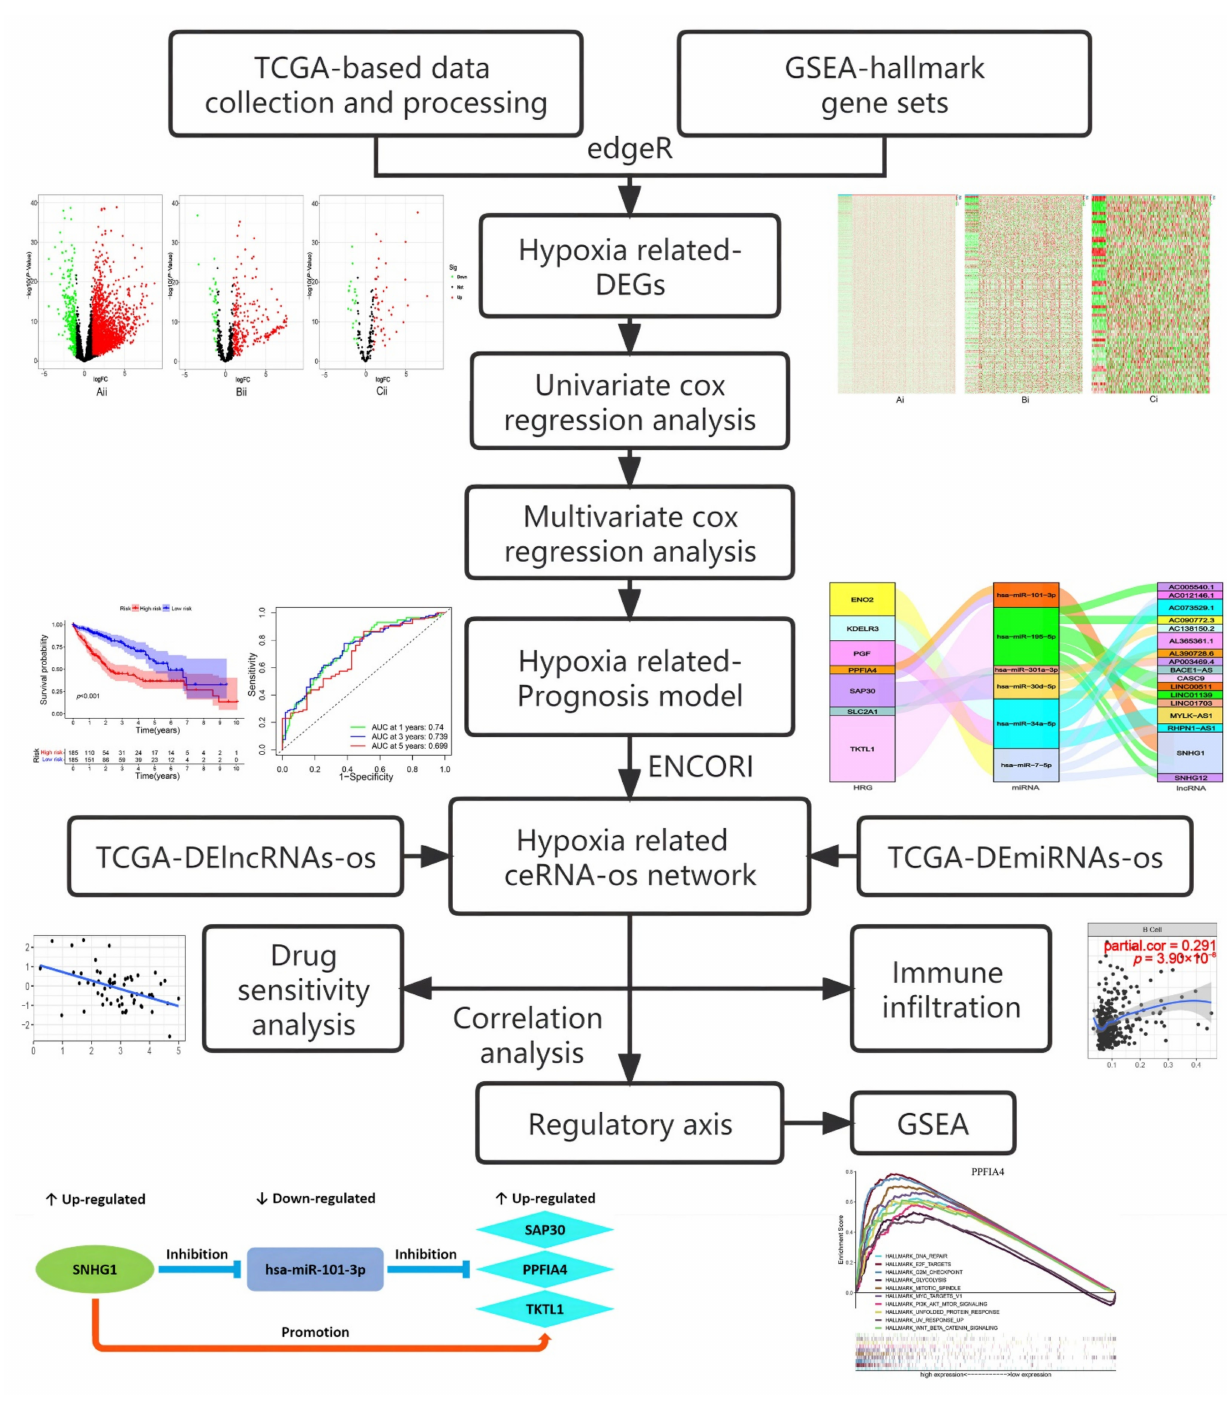
Figure 1. The workflow of this study: Analysis of hypoxia-related prognostic biomarkers and key axes. The diagram contains specific bioinformatics approaches, data mining tools, and partial analysis